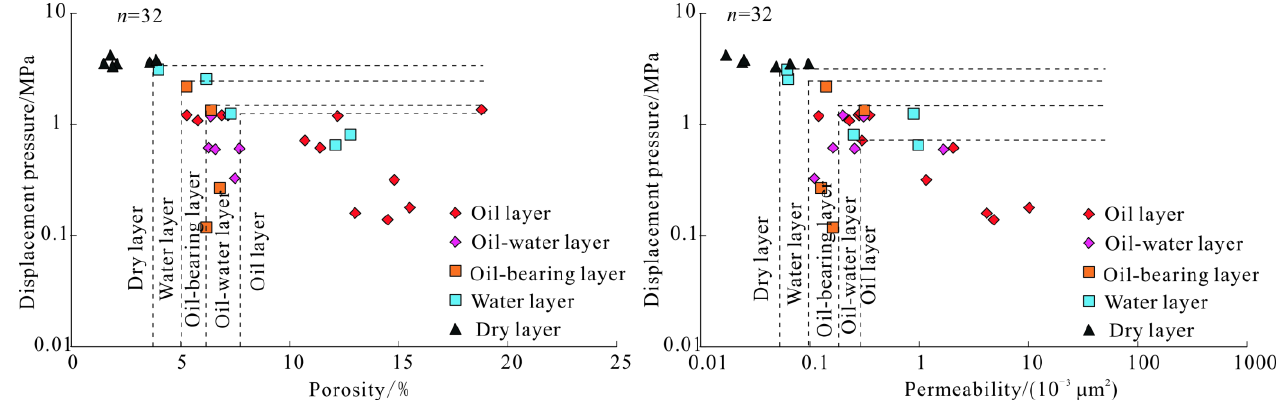
Figure 8. Displacement pressure vs. porosity and permeability for the volcanic reservoir in the Chepaizi Uplift.